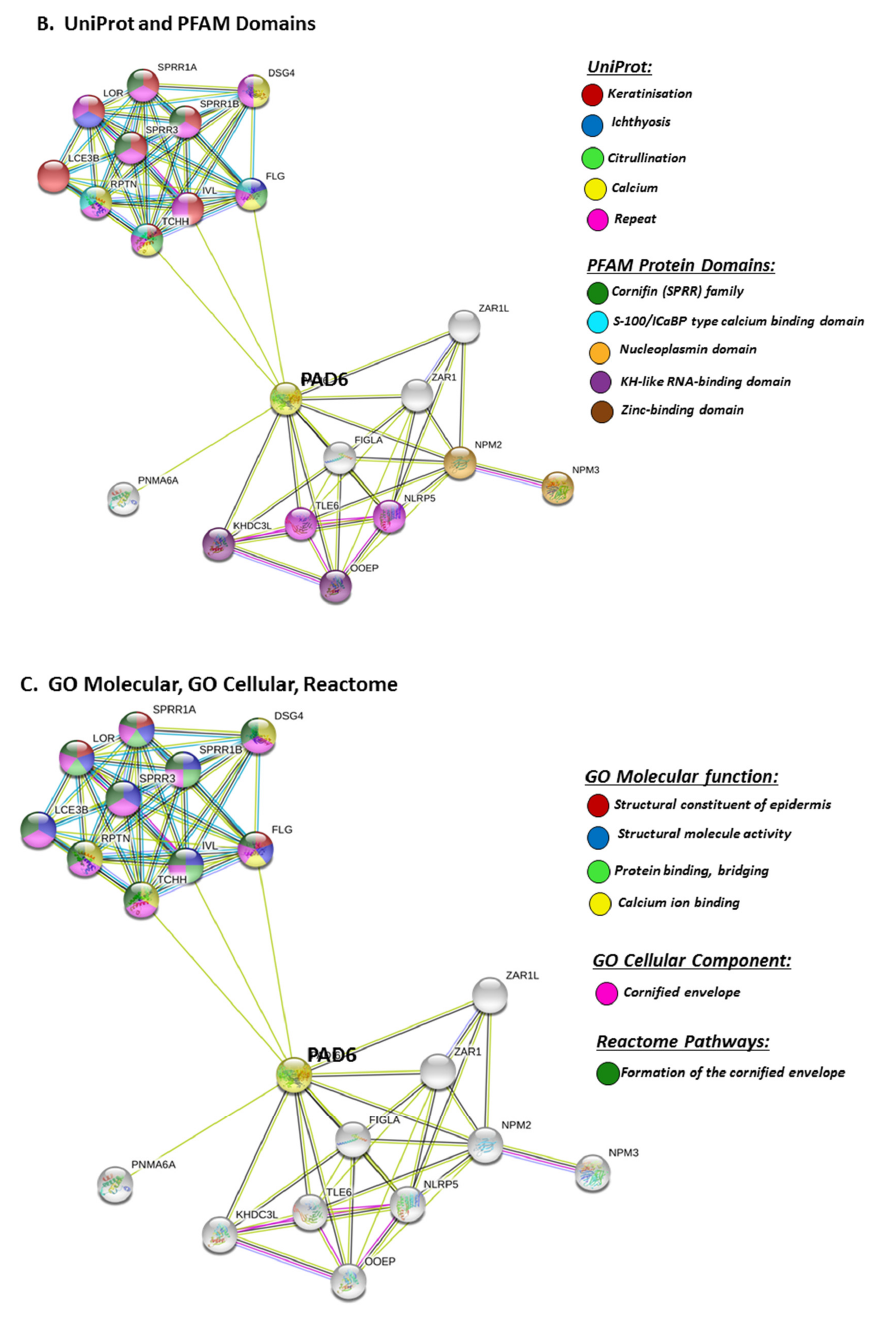
Figure 9. GO and KEGG analysis for PAD6, highlighting GO biological pathways ( A ) UniProt keywords and PFAM domains ( B ) and GO Molecular, GO cellular and Reactome pathways ( C ) Colour code for the di ff erent pathways is shown within the figure. Individual coloured lines represent specific protein interactions that have been identified through interactions that are known (referring to experimentally determined connections and curated databases), through interactions that are predicted (referring to gene fusion, gene neighbourhood, gene co-occurrence) or through interactions identified via text mining, co-expression or protein homology (please refer to the colour key provided in the figure for the di ff erent connective lines) (PPI enrichment p -value: 1. 0 × 10 − 16